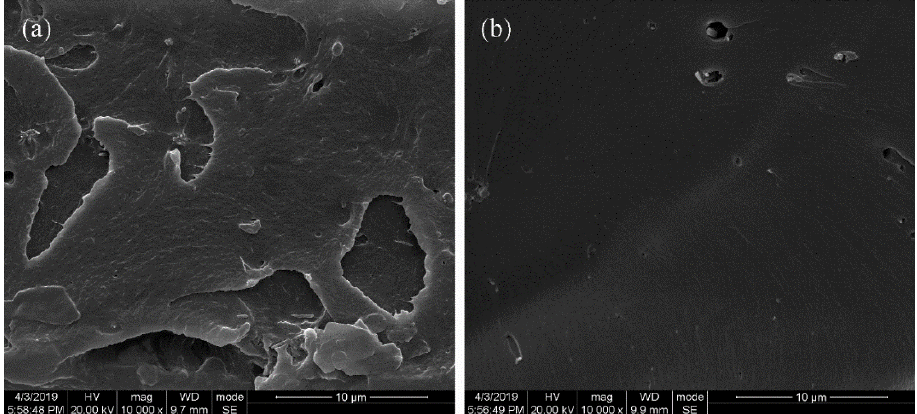
Figure 8. SEM of the fracture surface of PEN–OH films. ( a ) without heat-treatment ( b ) cured at 340 °C.